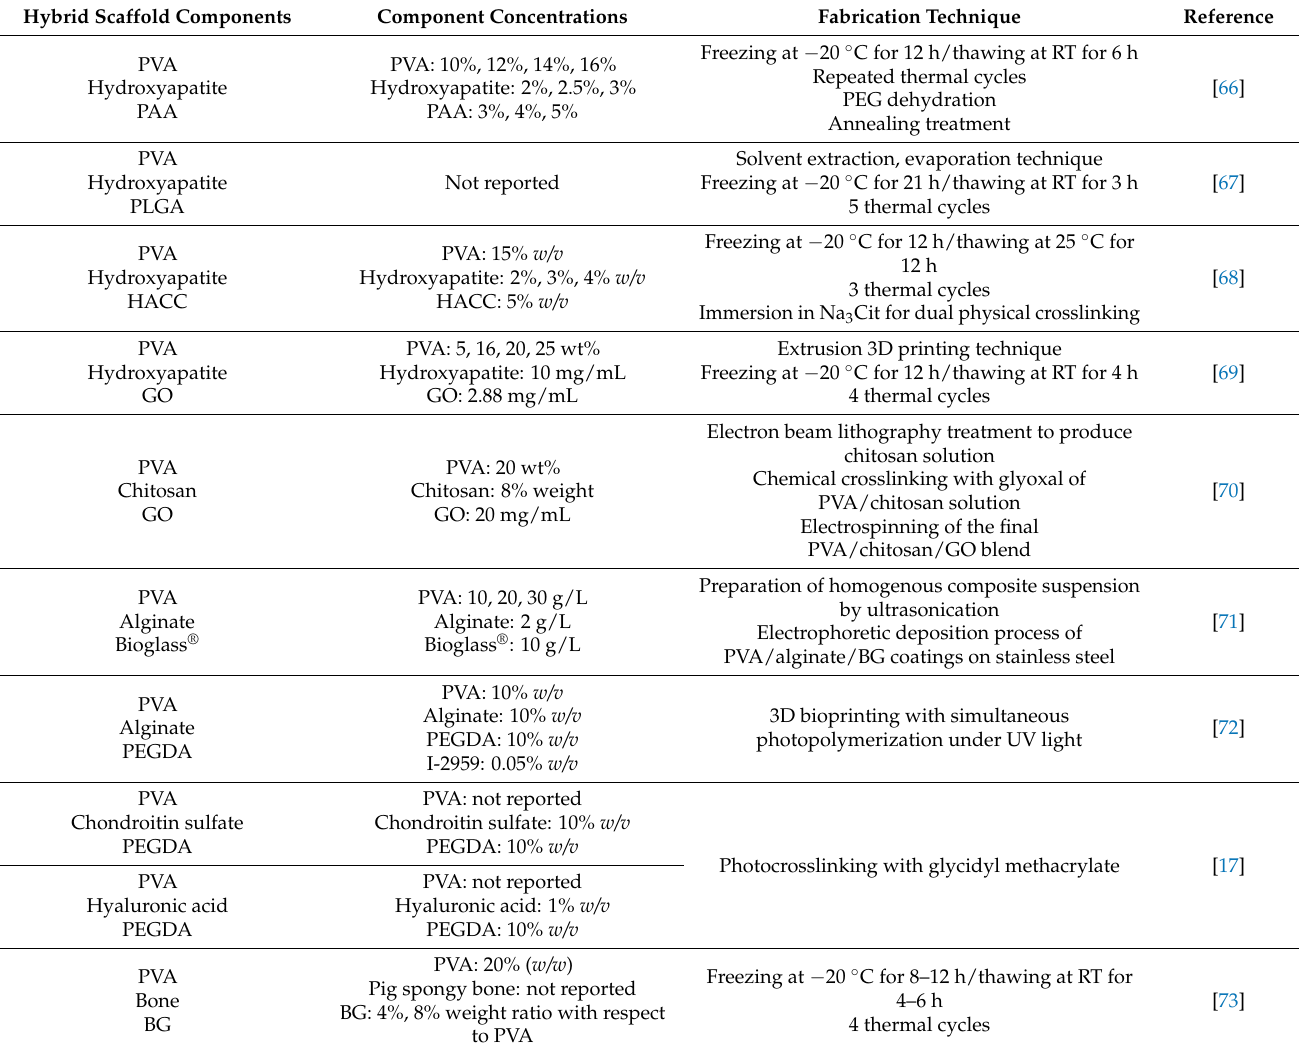
Table 2. Composition and fabrication methods of PVA/natural + synthetic materials blends for cartilage TE. Hybrid Scaffold